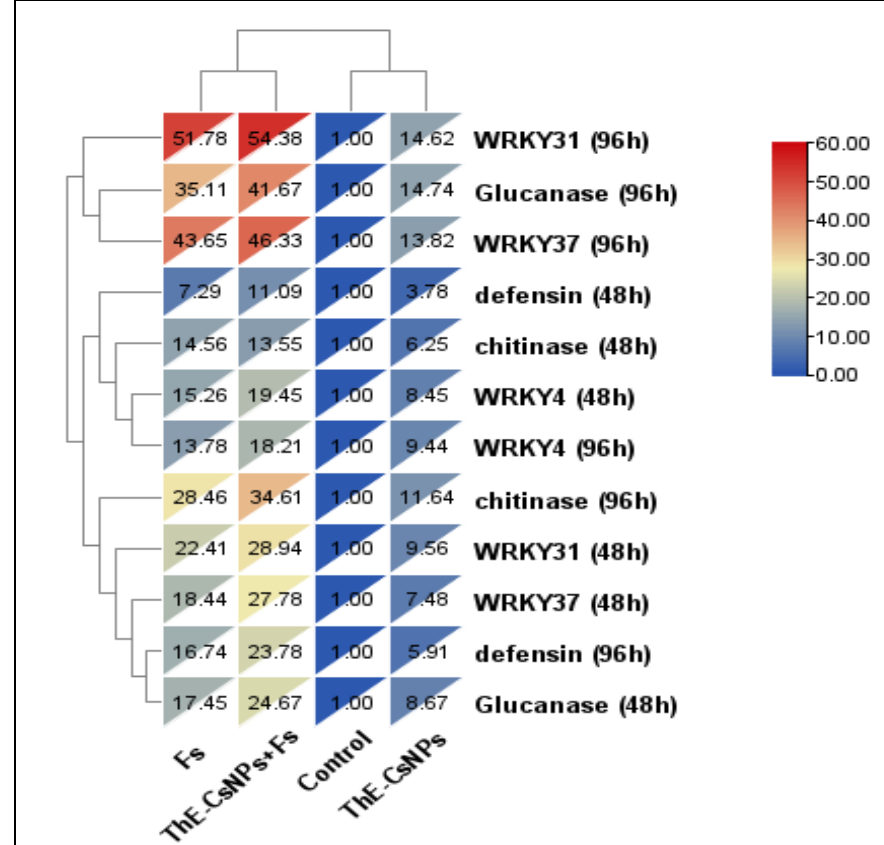
Figure 7. Hierarchical clustering heat map of transcriptional expression of three WRKY transcription factors and some defense-related genes in tomato plant infected with F. solani and/or primed with ThE-CsNPs (1%) after 2 and 4 days post F. solani inoculation. Where, C: untreated control, Fs: